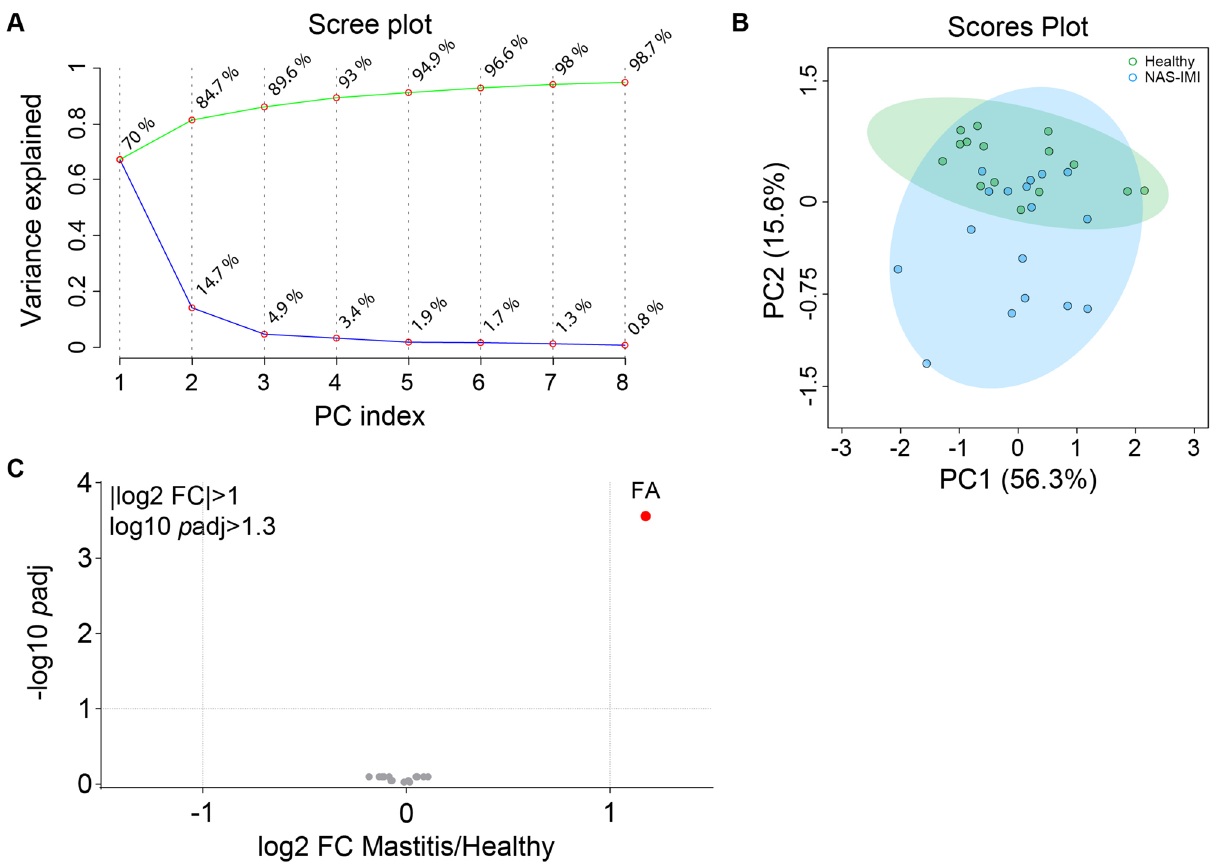
Figure 6. Lipid classes do not discriminate the lipidome of NAS-IMI and H water buffalo milk. ( A ) Scree plot of the principal component analysis (PCA) representing the total variance (green line) and the single variance (blue line) explained for each component (PC index). ( B ) 3D scatter plot of the PCA representing sample distribution based on PC1, PC2, and PC3 of lipidomic profiles of healthy (pink) and NAS-IMI (cyan) milk samples. ( C ) Volcano plot representing down-, upregulated (red dot) and unchanged lipid classes (grey dots) in NAS-IMI compared to H buffalos. Significant lipid classes were considered with |log2 fold-change|> 1 and − log10 adjusted p value >